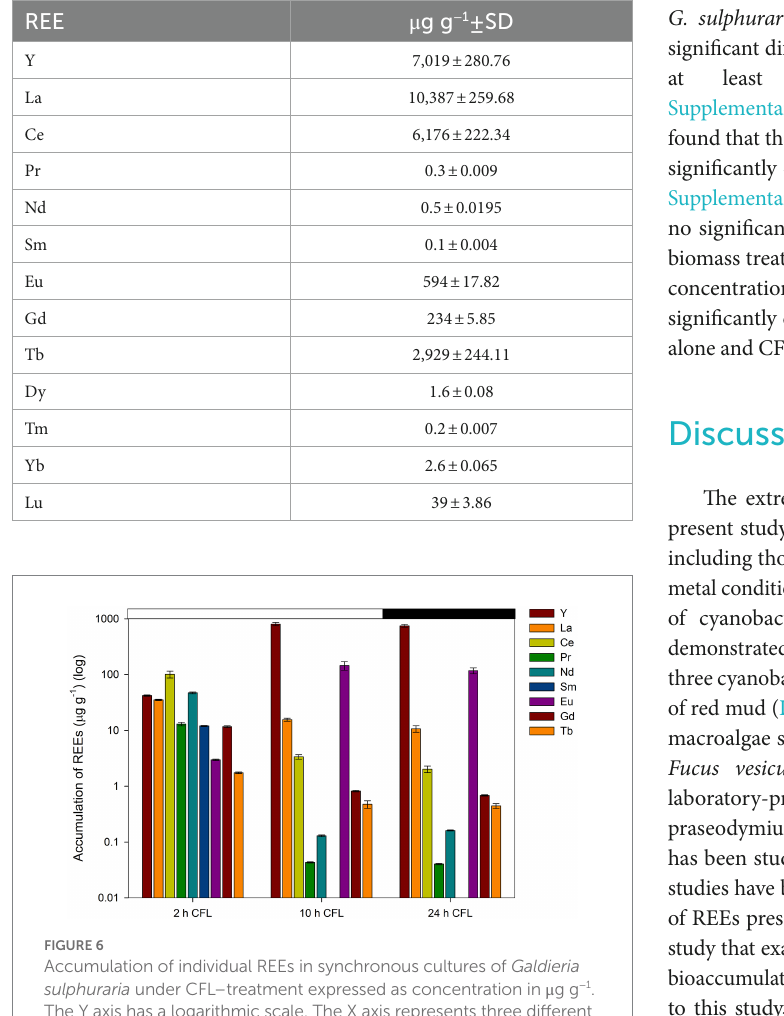
TABLE 1 Concentration of individual REEs in a CFL acid